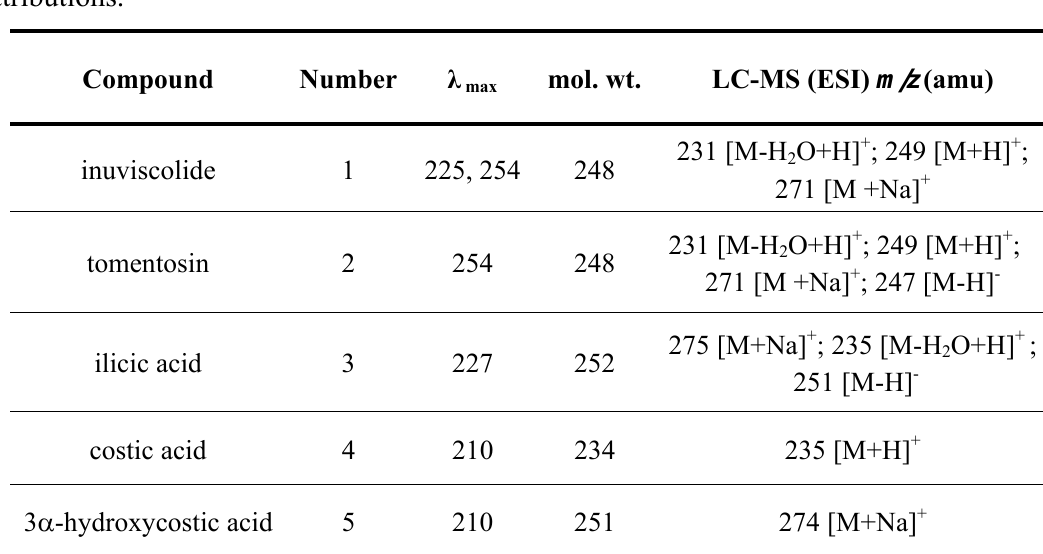
Table 2. Main signals exhibited in the HPLC-MS 2 spectra of compounds detected in D. viscosa extract and UV Maxima ( λ